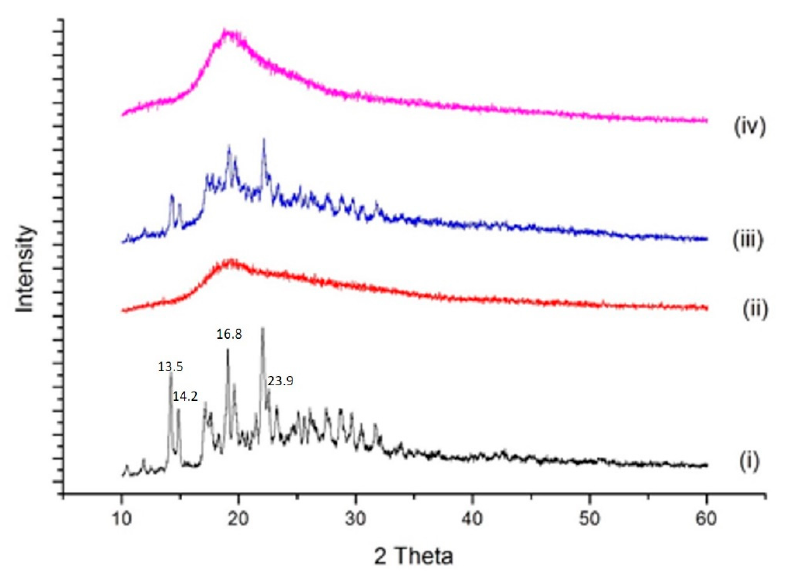
Figure 4. XRD spectra of bedaquiline (i), SBE- β -CD (ii), the physical mixture of bedaquiline and SBE- β -CD (iii), and the inclusion complex BDQ-CD (iv).